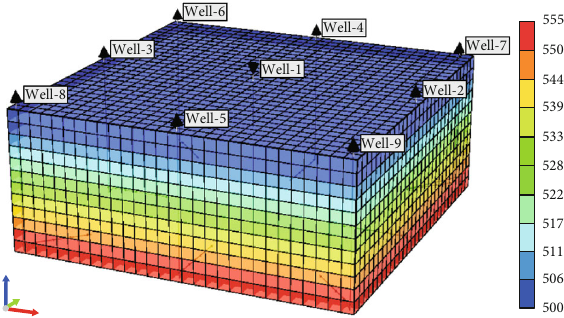
Figure 1: CMG model